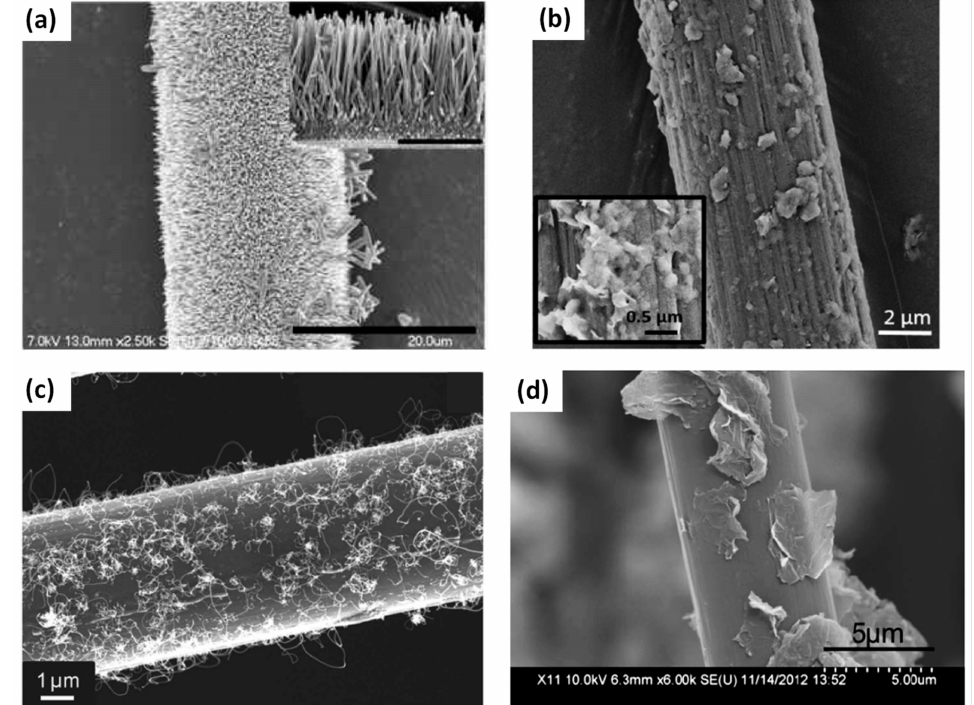
Figure 5. SEM images of hierarchical synthetic fibres ( a ) aligned ZnO nanowires coated and grown on aramid fibres (functionalized with carboxylic acid groups); ( b ) Si-nanoclays (nanoclays functionalized with APTES) grafted on N-CF (carbon fibre modified with GTMAC); ( c ) CNTs grown on oxidized IM7 carbon fibres using CVD method; ( d ) graphene nanosheets deposited on carbon fibre at a content of 1 wt% (reprinted with permission from Ehlert and Sodano 2009 [56], Zabihi et al., 2017 [50], Qian et al., 2010 [57] and Chen et al., 2015